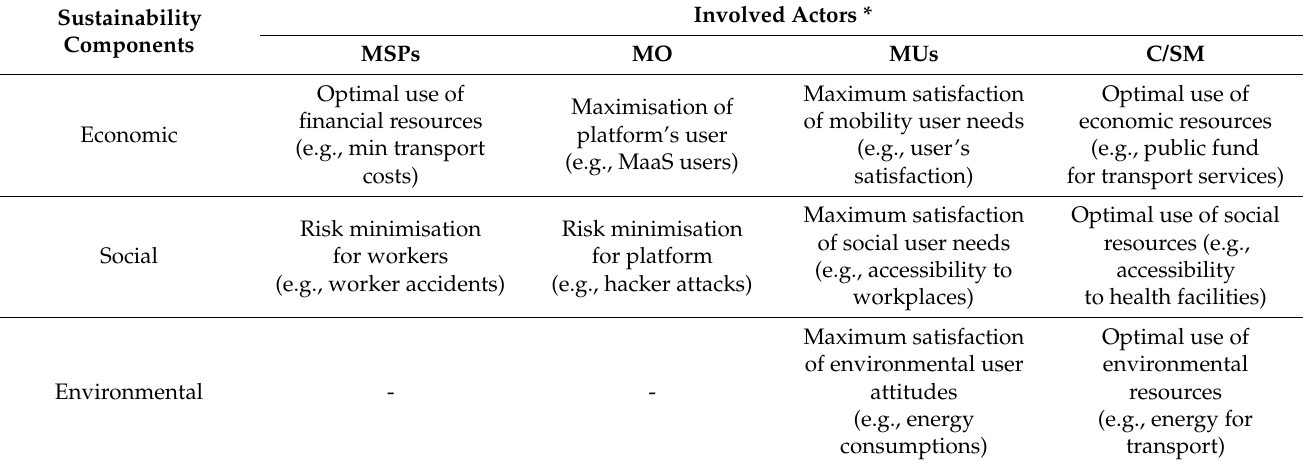
Table 5. Objectives expressed in relation to sustainability component and involved actors.